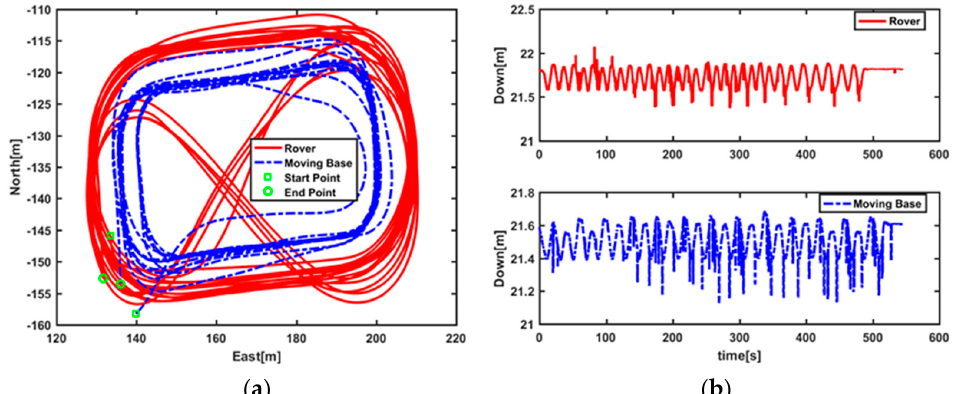
Figure 8. Trajectories of vehicles in test 1. ( a ) Horizontal direction; ( b ) vertical direction.